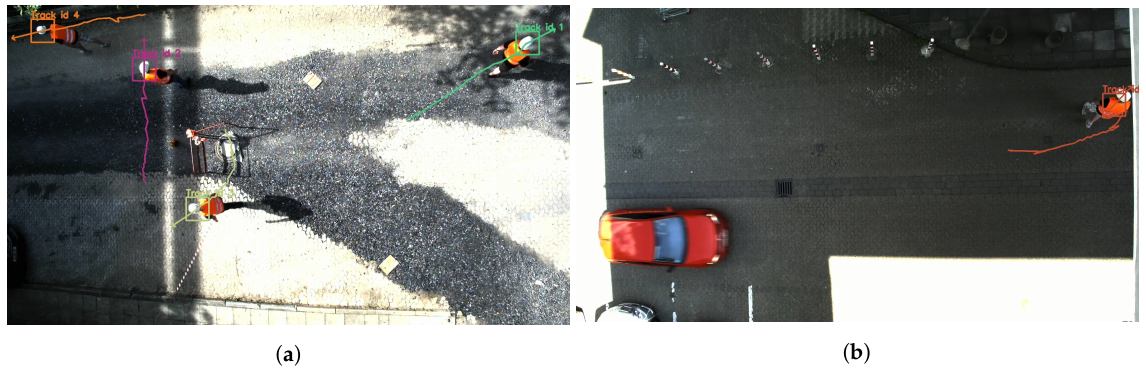
Figure 9. Examples of the classical tracking system applied to different scenes. ( a ) An example of the tracking system applied to Scene 2 shows that the tracking is sufficient even on slightly overexposed scenes. ( b ) On Scene 3, the tracking results show that the worker is tracked successfully while the moving vehicle remains untracked as intended.